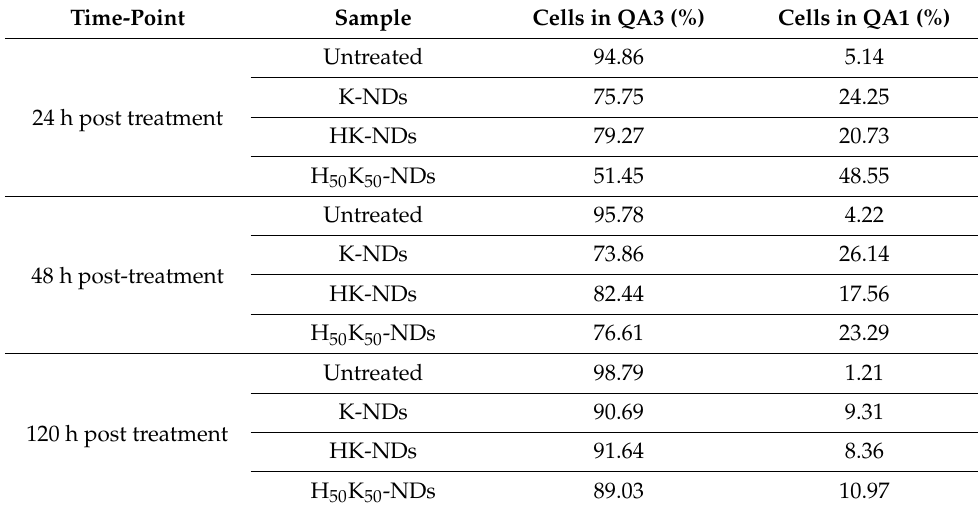
Table 2. Cellular internalization of NDs in after 24, 48 and 120 h post-treatment. Shift to QA1 corresponds to higher side scattering attributed to the internalized NDs. Time-Point Sample Cells in QA3 (%) Cells in QA1 (%) Untreated 94.86 5.14 K-NDs 75.75 24 h post treatment HK-NDs